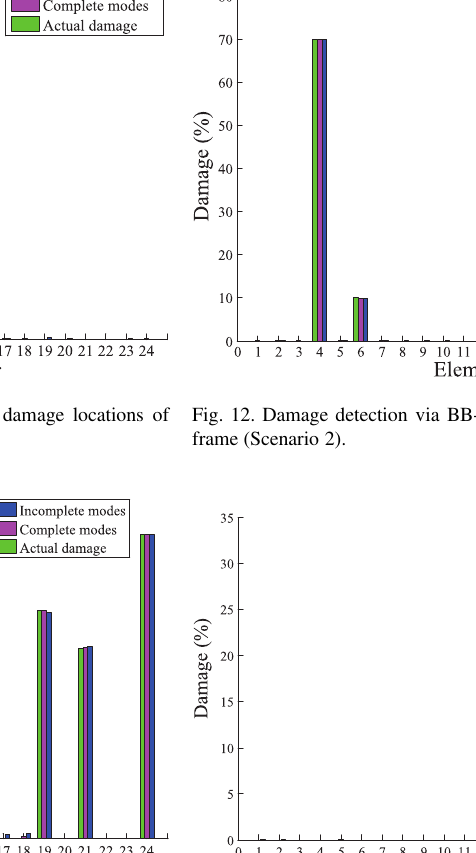
Fig. 13. Damage detection via BB-BC for a large number of damage locations of frame (Scenario 3).